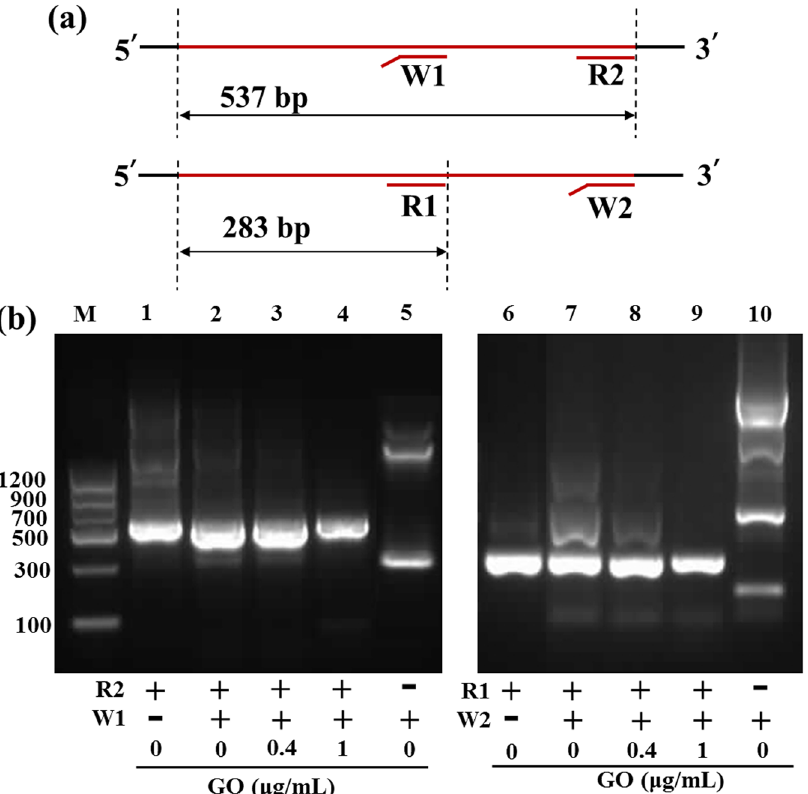
R2 + W1). ( b ) The effect of GO on DNA amplification in a semimultiplex PCR. Target sequences for R1 and R2 were 283 and 537 bp, respectively. The final concentrations of R1, W1, R2 and W2 were 20 nM. PCR products were analyzed by agarose gel electrophoresis (1.5%). Lane M is markers.